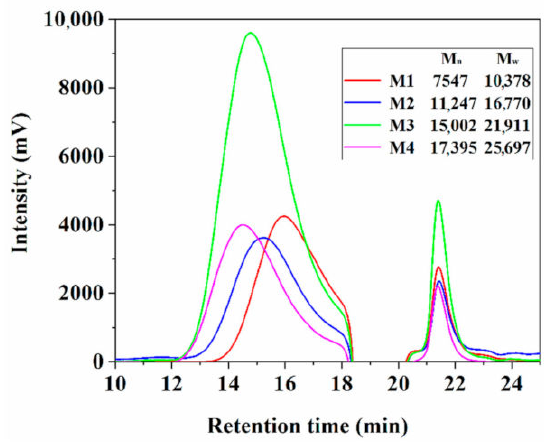
Figure 5. GPC results and molecular weights of four sizing